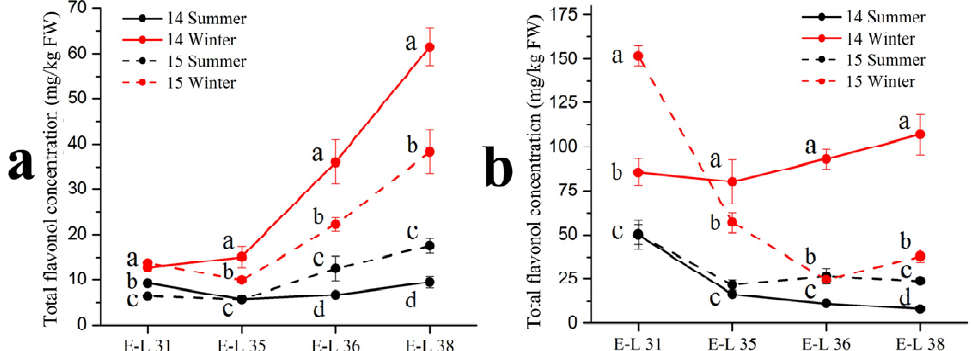
Figure 2. Total flavonol concentration in Muscat Hamburg grape ( a ) and Victoria grape ( b ) in 2014 and 2015 under the double cropping system. Different letters within the same development stage indicate significant differences among seasons (Duncan’s multiple range test at p <